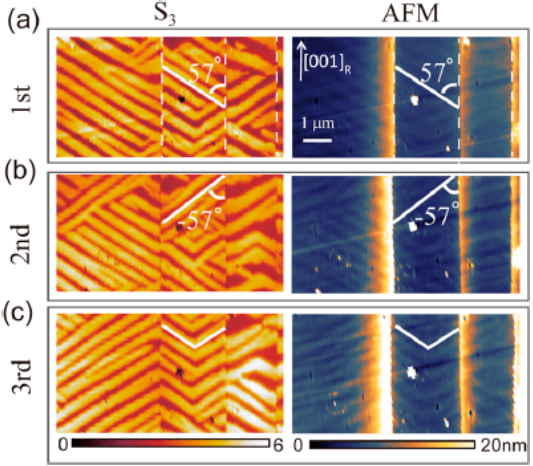
Figure 8. AFM and SNOM images of a VO 2 film undergoing 18.8 mW pump laser induced strain. The left side of ( a – c ) show SNOM (S 3 ) images with AFM images on the right. The pump laser was switched off for 1 s between each scan. After each switch, patterns are formed due to a spontaneous structural symmetry breaking, with stripes aligning along two possible orientations of the monoclinic c -axis shown by white lines. Reproduced with permission from [56], Copyright Applied Physics Letters, 2014.